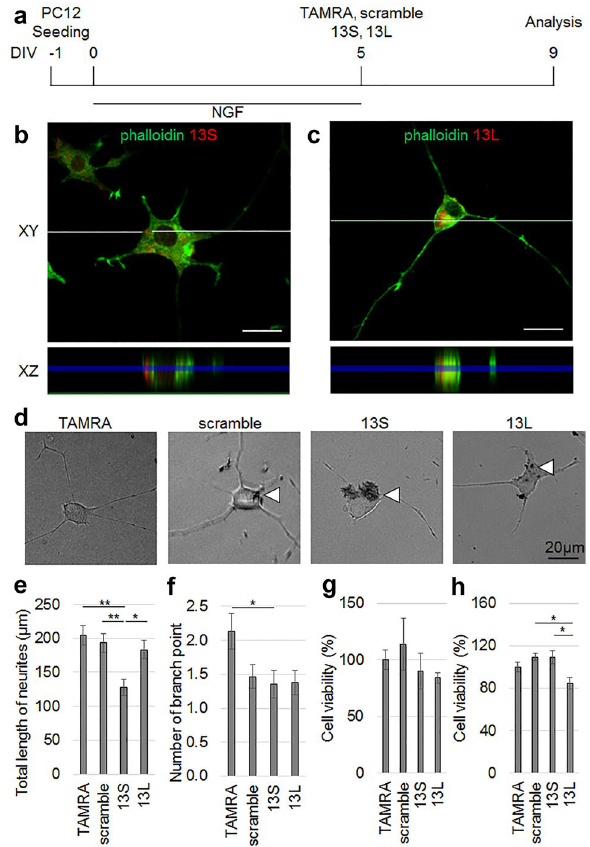
Figure 2. Entry of aggregated 13S leads to retraction of neurites of differentiated PC12 cells. ( a ) Time schedule of the experiment. ( b , c ) z-stacks confocal images of differentiated PC12 cells with an interval of every 1 µm were obtained on day 4 after application with the peptides. Ortho XZ-axis cross section images (bottom) along the white line in the XY-axis view (top) were reconstituted from the z-stacks. The 13S ( b ) and 13L ( c ) signals (red) are located between phalloidin signals (green). ( d – f ) Morphology of differentiated PC12 cells given TAMRA, scrambled serine, 13S or 13L (n = 45 cells, each from 3 experiments). Representative images are shown in ( d ). The morphological indices that reflect degeneration of neurons are total length of neurites ( e ) and number of branch point ( f ). Arrowheads indicate aggregates. ( g , h ) The viability of differentiated (n = 5, 10, 5 and 5 for TAMRA, scrambled serine, 13S and 13L, respectively) ( g ) and undifferentiated (n = 5 each) ( h ) PC12 cells were studied at 1 day after application of the peptides. The values relative to those of TAMRA-treated cells are expressed. Error bars represent SE. ANOVA, * p < 0.05, ** p < 0.01. Scale bars, 20